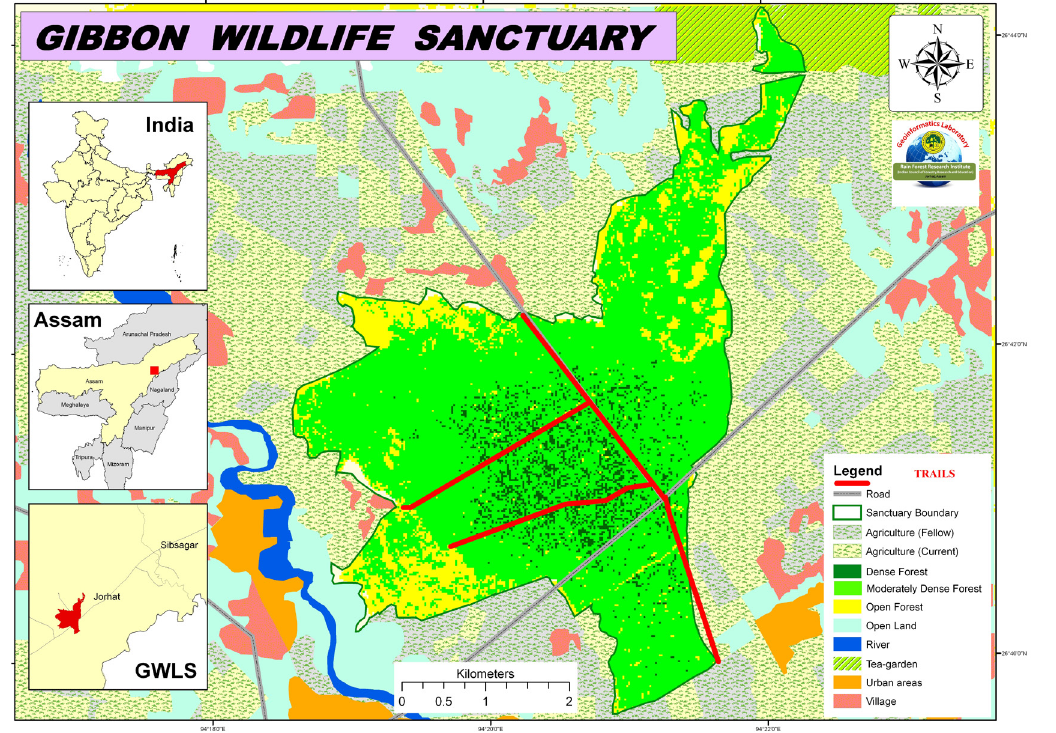
Figure 1. The Gibbon Wildlife Sanctuary with the butterfly sampling trails, marked in red (Source: D.J. Das, Geo Informatics Laboratory, Ecology & Biodiversity Conservation Division, RFRI,